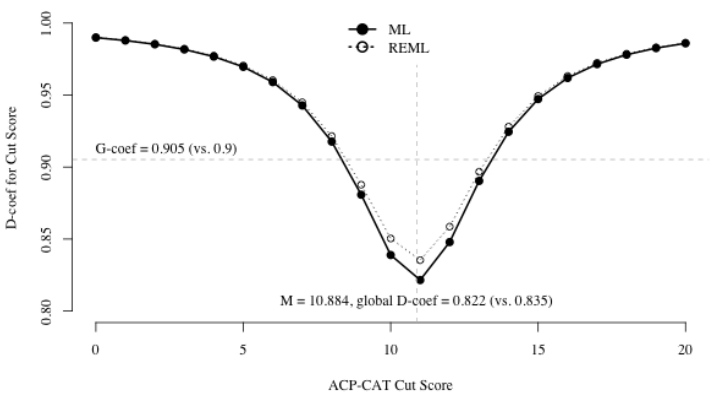
Figure 4. D-coefficients for cut-scores on ACP-CAT scale totals, using p × r data from Task 1, estimated with ML in lavaan (vs. REML in gtheory